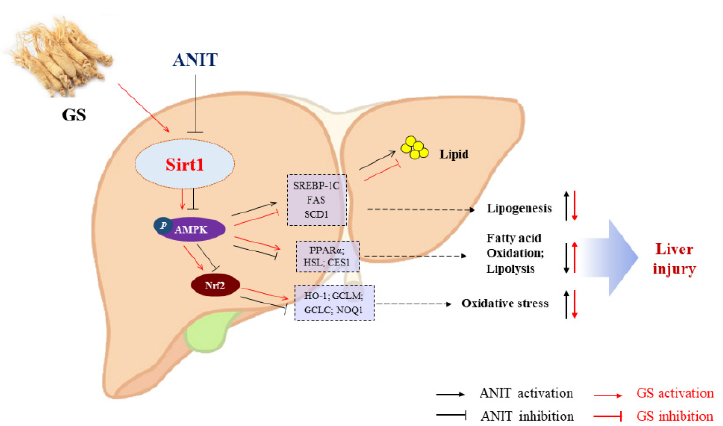
Figure 11. The proposed mechanism of GS-mediated protection in IC via the activation of the SIRT2/AMPK pathway. GS increases expression of SIRT1, leading to phosphorylation of AMPK and Nrf2, and the subsequent modulation of genes associated with inhibiting hepatic lipogenesis and increasing hepatic fatty acid oxidation and lipolysis.